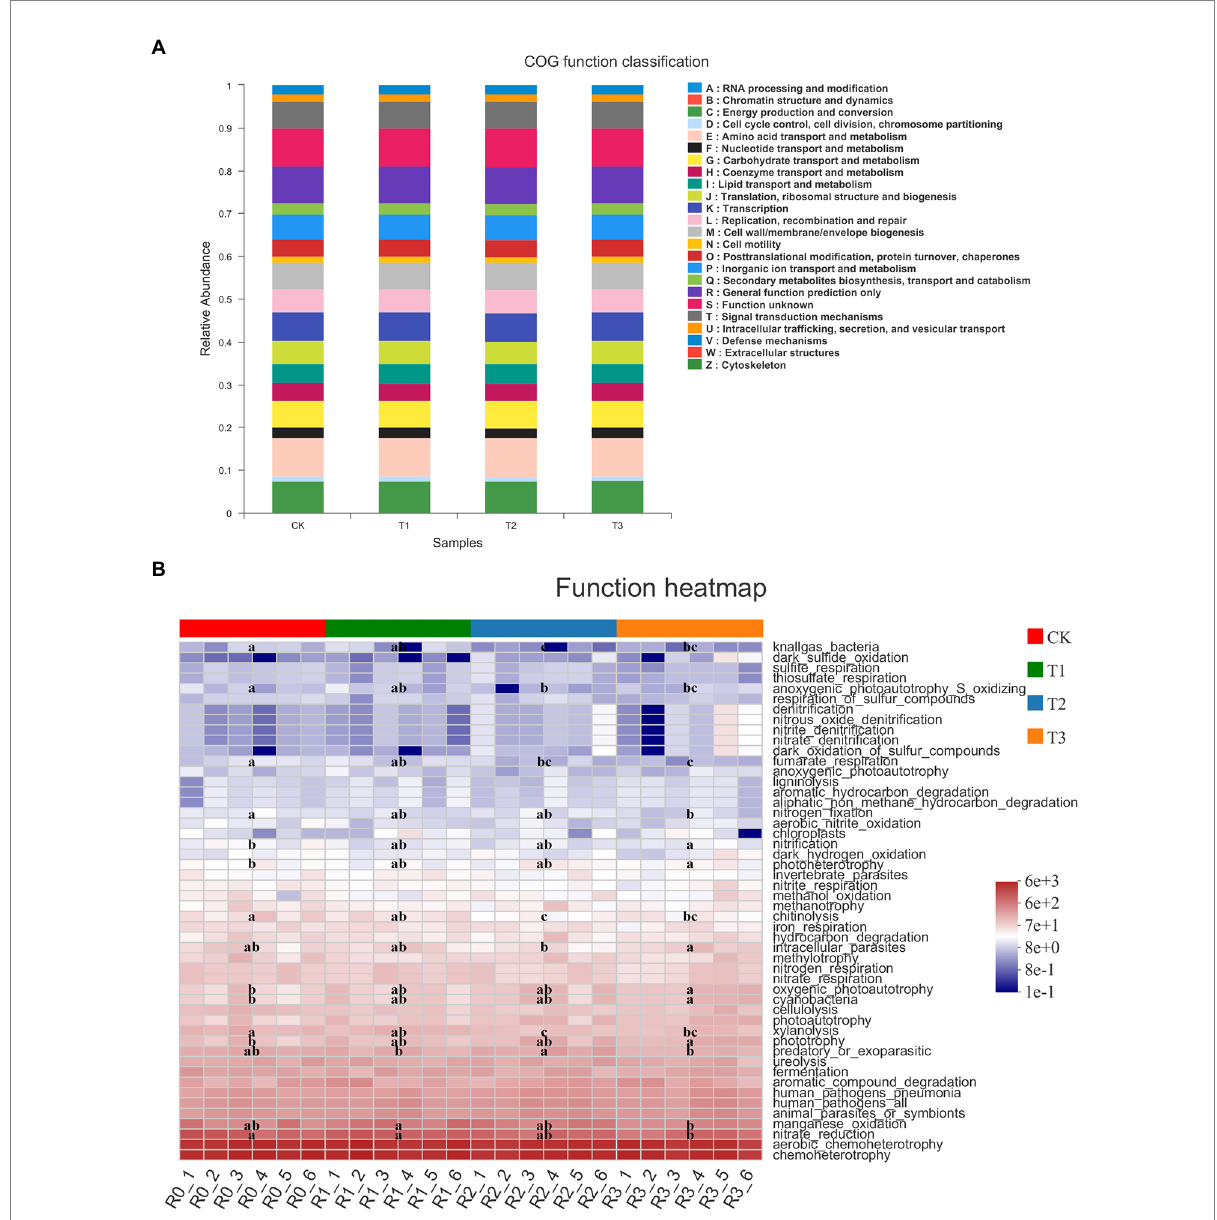
FIGURE 5 Clusters of Orthologous Groups (COG) functional classification of PICRUSt in bacteria (A) of different treatments. The functional heatmap predicated by FAPROTAX in bacteria (B) under different treatments. n = 6; different letters indicate significant differences ( p <